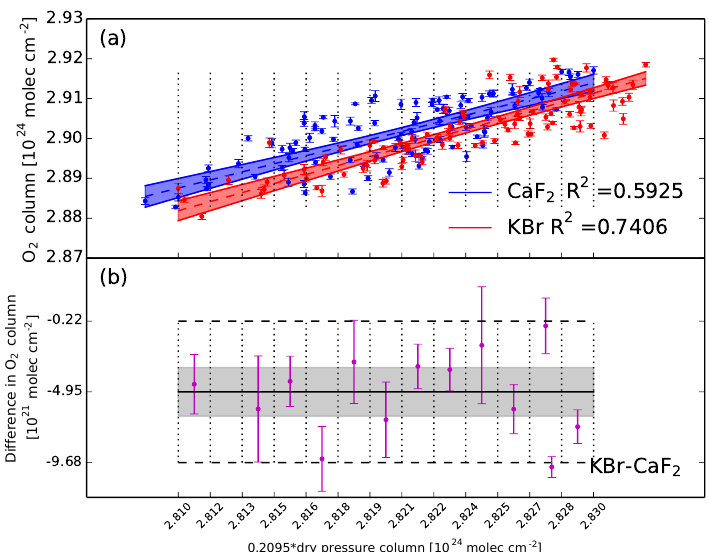
Figure 8. (a) shows the coincidences between the hourly means of the O 2 from the KBr (red) and CaF 2 (blue) ensembles and the O 2 column obtained from the dry pressure column with a linear regression of the two sets, with the shaded area representing a 95% confidence interval. (b) shows the difference of means of KBr and CaF 2 (purple points) for each bin (vertical lines) in a Bland–Altman plot, with the black dashed lines showing the standard deviation of all points. The black solid line represents the bias and the shaded area the standard error of the bias, both reported in Table 6.